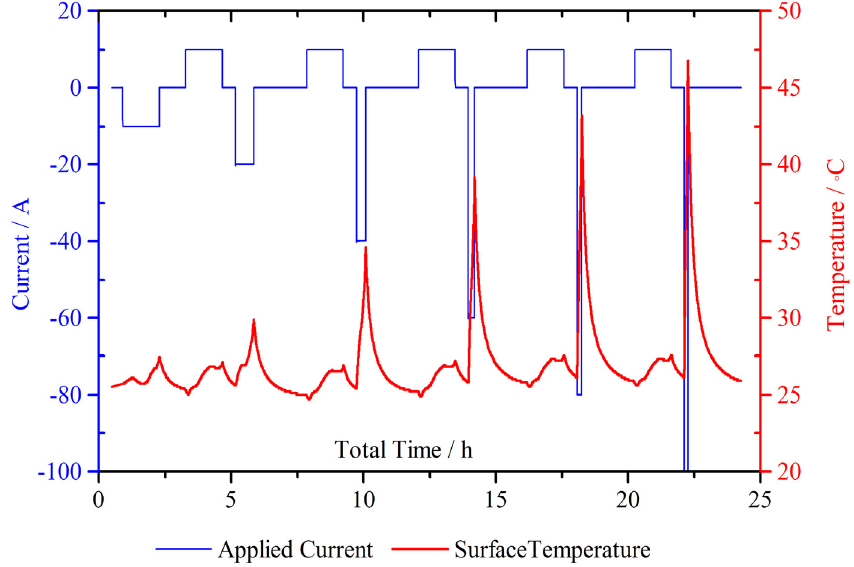
Figure 5. Thermistor (placed near the positive tab of the cell) based temperature profile (red line) of an LFP cell and the corresponding load profile (blue line) during a continuous charge at 10 A and discharge at 10 A, 20 A, 40 A, 60 A, 80 A and 100 A. Discharge is denoted by negative